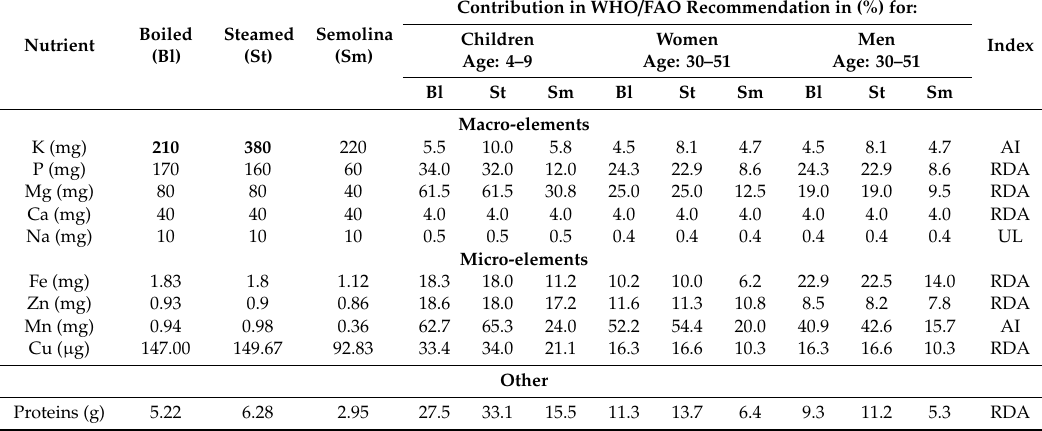
Table 4. Contribution of 50 g of di ff erent forms of quinoa the recommended daily intake of children, women, and men according to WHO and